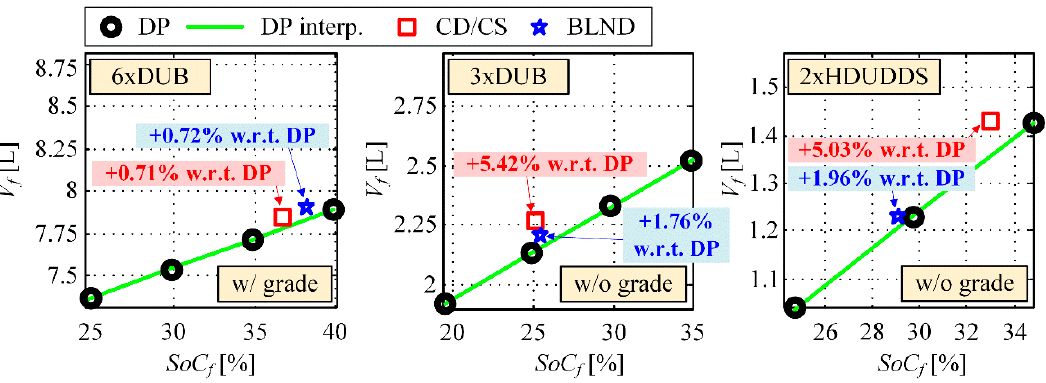
Figure 14. Total fuel consumption for CD / CS and blended regimes, plotted against DP optimal results for different driving cycles and no LEZ case.